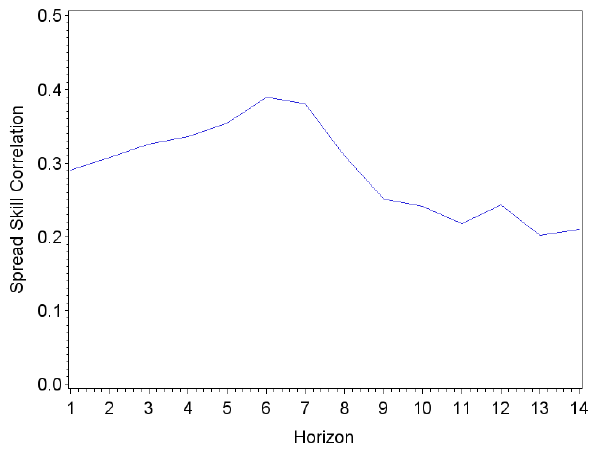
Fig. 2. Correlation between ensemble prediction system (EPS) in- terquartile range and forecast error, using EPS mean as a determin- istic